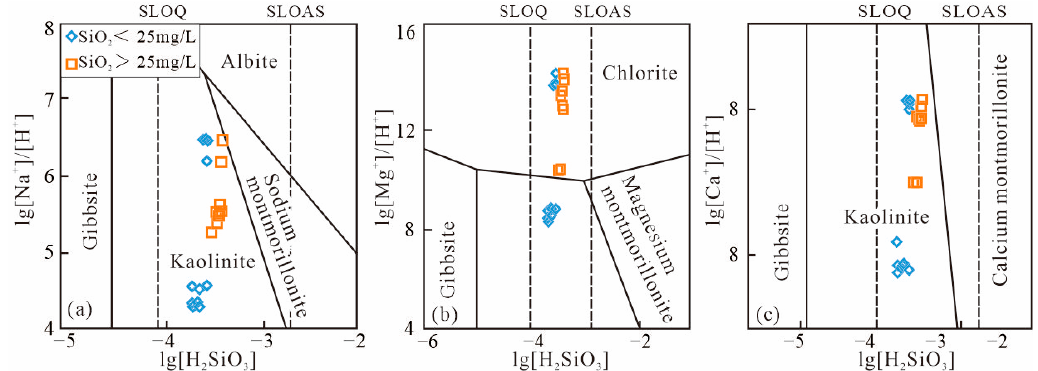
Figure 9. Mineral equilibrium phase diagram for the groundwater in the study area. SLOQ = saturation line of quartz; SLOAS = saturation line of amorphous SiO 2 . ( a ): the [Na + ]/[H + ]-H 2 SiO 3 system; ( b ): the [Mg 2+ ]/[H + ]-H 2 SiO 3 system; ( c ): the [Ca 2+ ]/[H + ]-H 2 SiO 3 system.